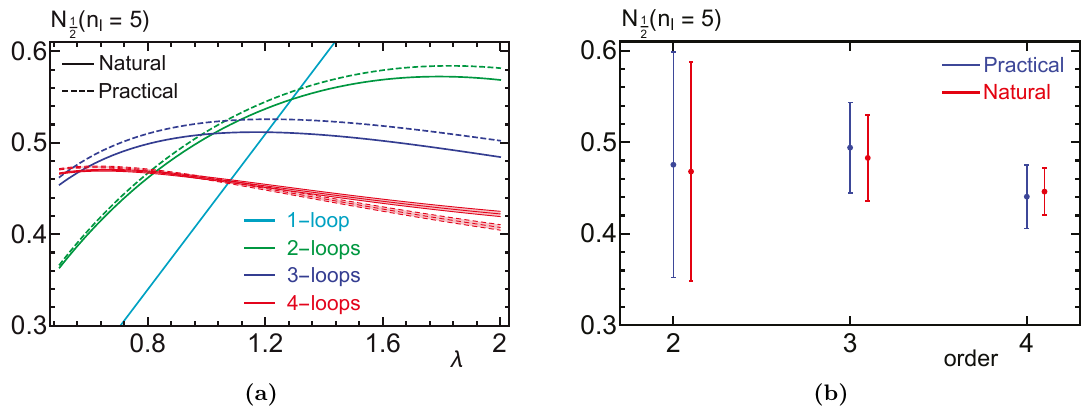
Figure 3. N ( n ‘ = 5) for the natural and practical top quark MSR masses. On panel (a) results 1 = 2 are shown as a function of (cid:21) including contributions from one to four loops. The size of the bands at four loops re(cid:13)ects the error introduced by the numerical uncertainty in the O ( (cid:11) 4 for the MS-pole conversion series. On panel (b) results are shown as error bars in blue (red) for the practical (natural) MSR masses at k -loops accounting also for the (cid:17) parameter variation as described after eq.